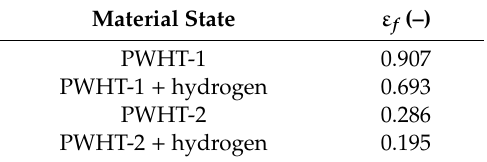
Table 3. Calculated values of true fracture strain for studied weldment in individual material